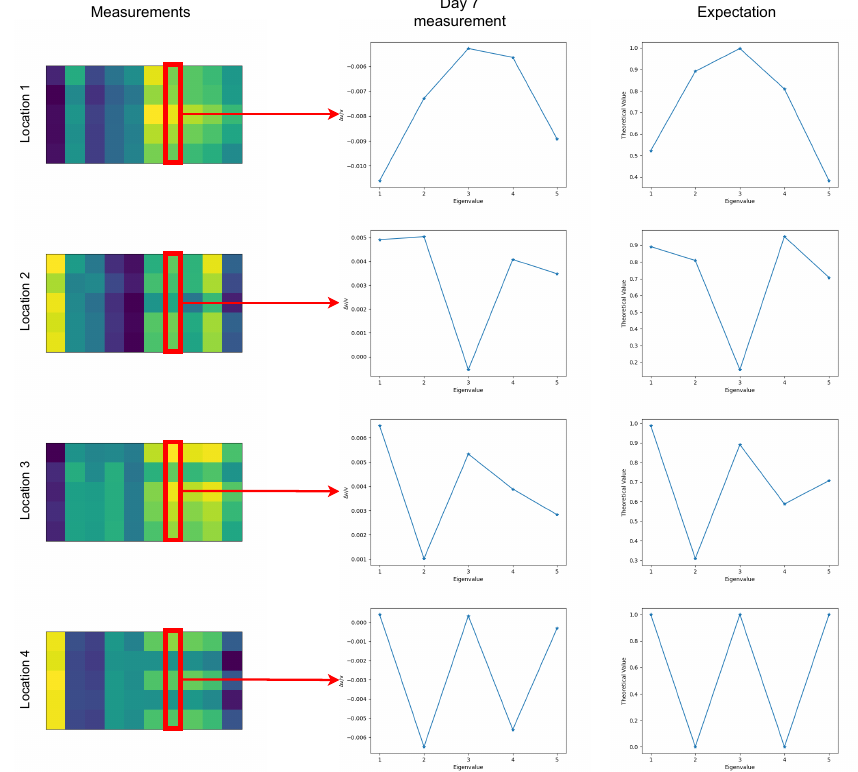
Figure 13. Examples of MIMs from the first five natural modes (first column), the measurement from the seventh day (second column) and the amplitudes of the corresponding modes at the location of the damage (third column). We can see that the pattern created because of the damage after the fifth day closely resembles the pattern of the modal amplitudes at the same